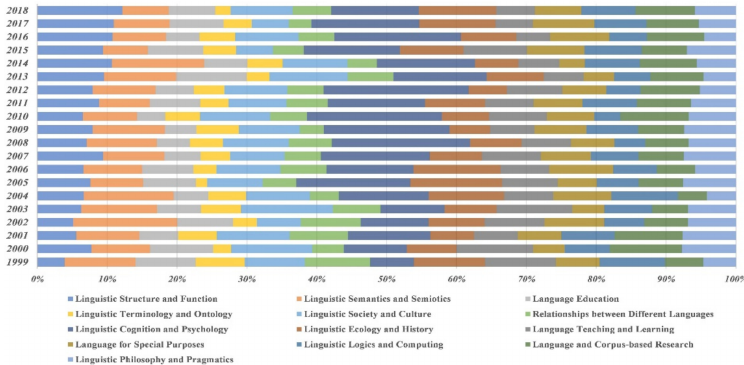
Figure 9. The topic distribution according to the integrated